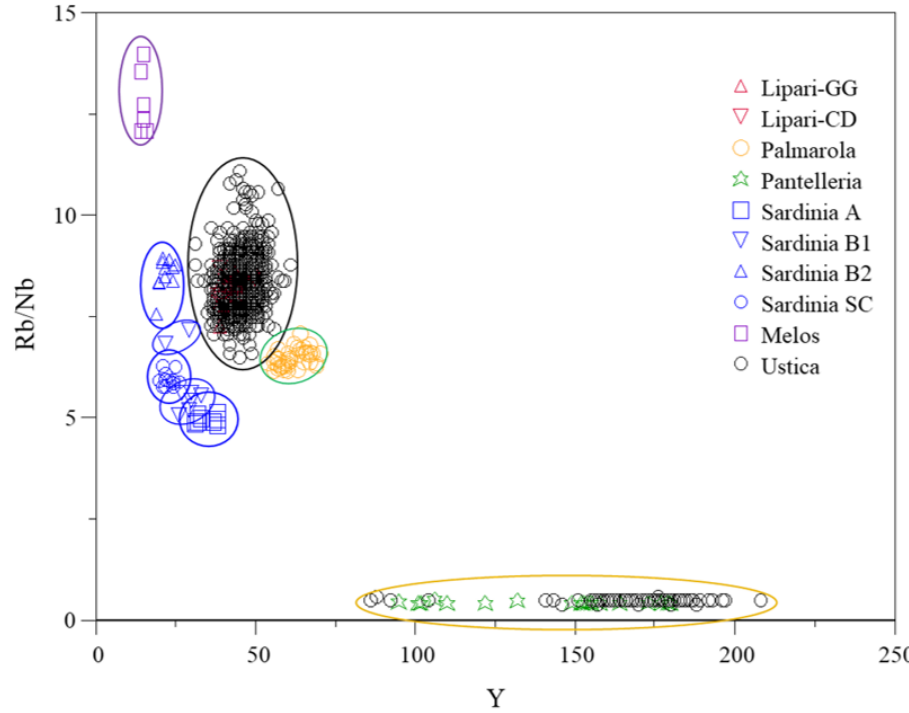
Figure 8: Graph of Y vs. Rb/Nb shows obsidian artifacts from Ustica matching with Lipari or Pantelleria.